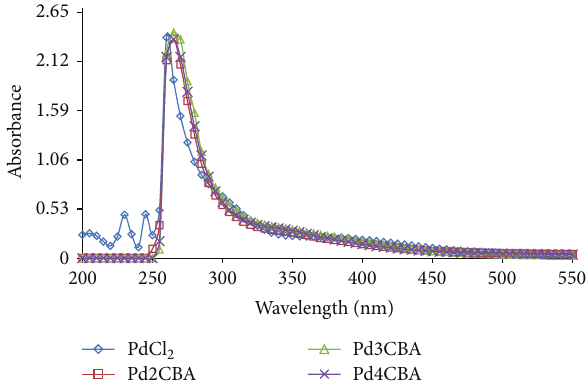
Figure 4: UV spectra of Pd (II) complexes in DMSO: water.